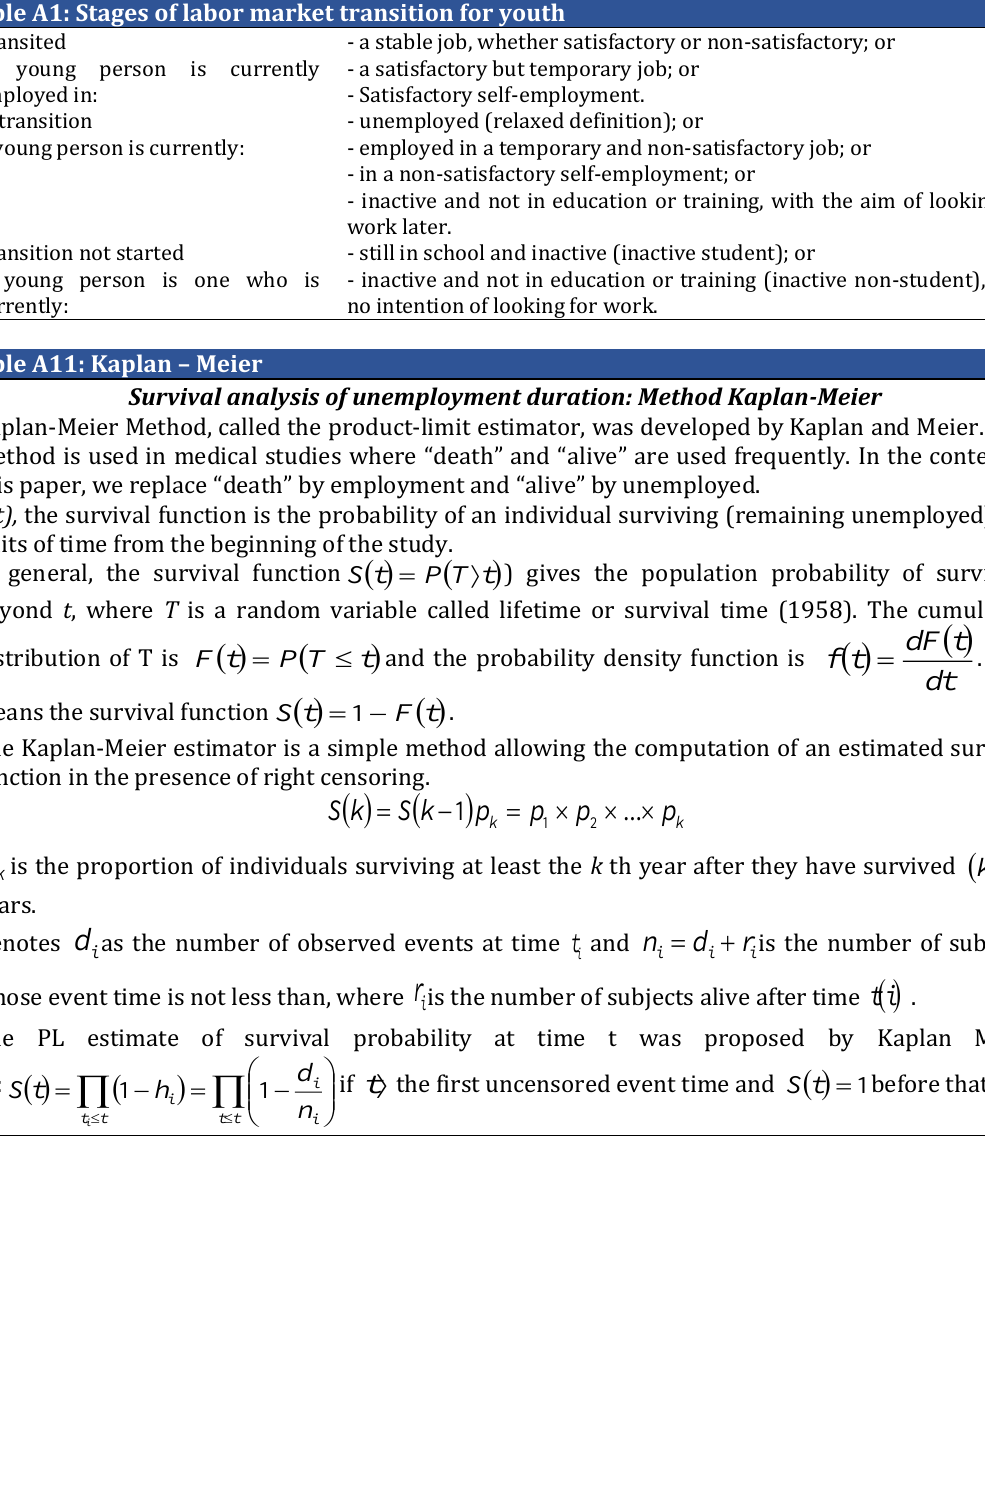
Table A1: Stages of labor market transition for youth